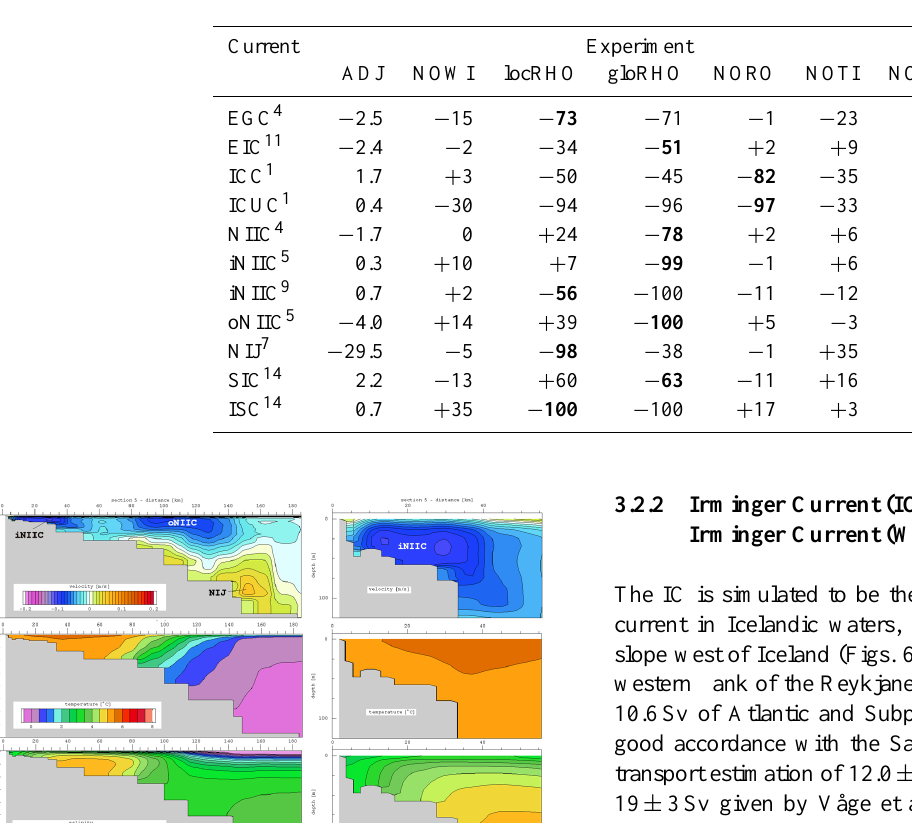
Table 3. Percentage change of the August to December 2003 mean volume flux of different currents (superscript number denotes the section) in the sensitivity experiments. Most notable changes are marked with bold numbers. The acronym ADJ denotes the model version with activated CTD data assimilation used for the long run. NIIC 4 denotes the sum of iNIIC 4 and oNIIC 4 . In case of experiment NORO only the December 2003 mean fluxes were considered.